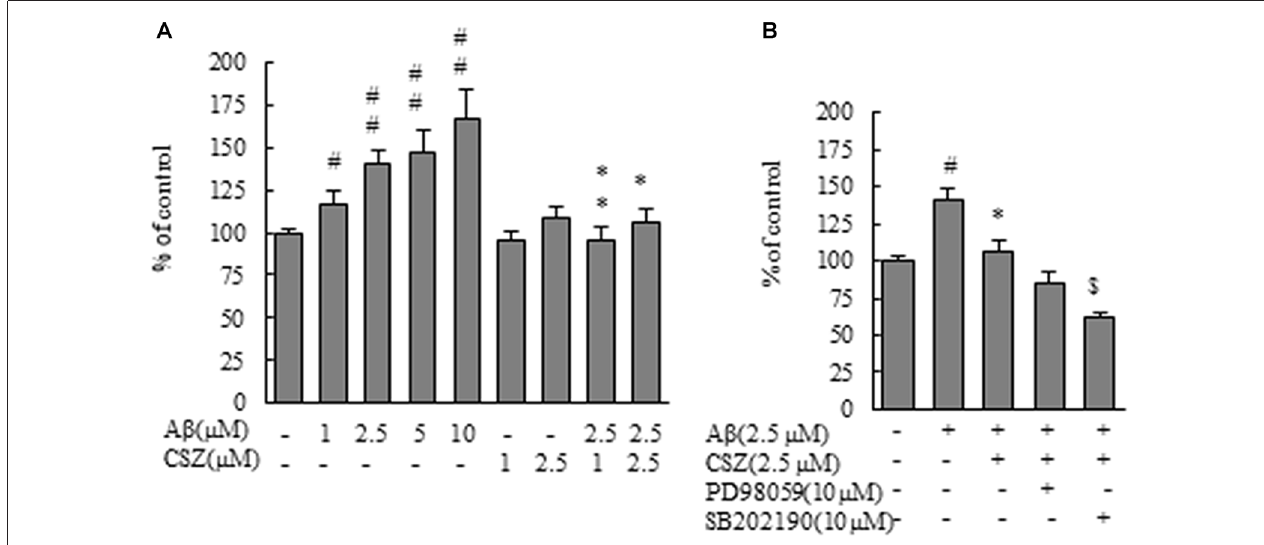
FIGURE 3 | Effect of CSZ on reactive oxygen species (ROS) generation in A β -stimulated SH-SY5Y cells. ROS generation in SH-SY5Y cells was evaluated using CM-H2DCFDA. (A) The generation of ROS in SH-SY5Y cells treated with A β (1–10 µ M) or CSZ (1, 2.5 µ M) for 1 h. (B) The generation of ROS was determined in SH-SY5Y cells incubated with or without 1 h pretreatment with CSZ or 10 µ M inhibitor of MEK1/2 or p38 MAPK followed by 1 h incubation with A β . ROS generation of the control cells was 1455290 ± 70201 Fluorescence intensity. Values are expressed as mean + SEM. # Compared vs. respective controls ( p < 0.05). ## Compared vs. respective controls ( p < 0.01). ∗ Compared vs. A β -treated cells ( p < 0.05). ∗∗ Compared vs. A β -treated cells ( p < 0.01). $ Compared vs. A β + CSZ-treated cells ( p <